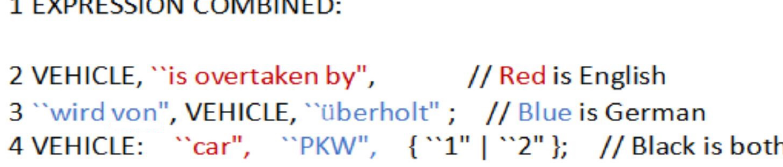
Figure 2. Bilingual characteristics of stiEF .